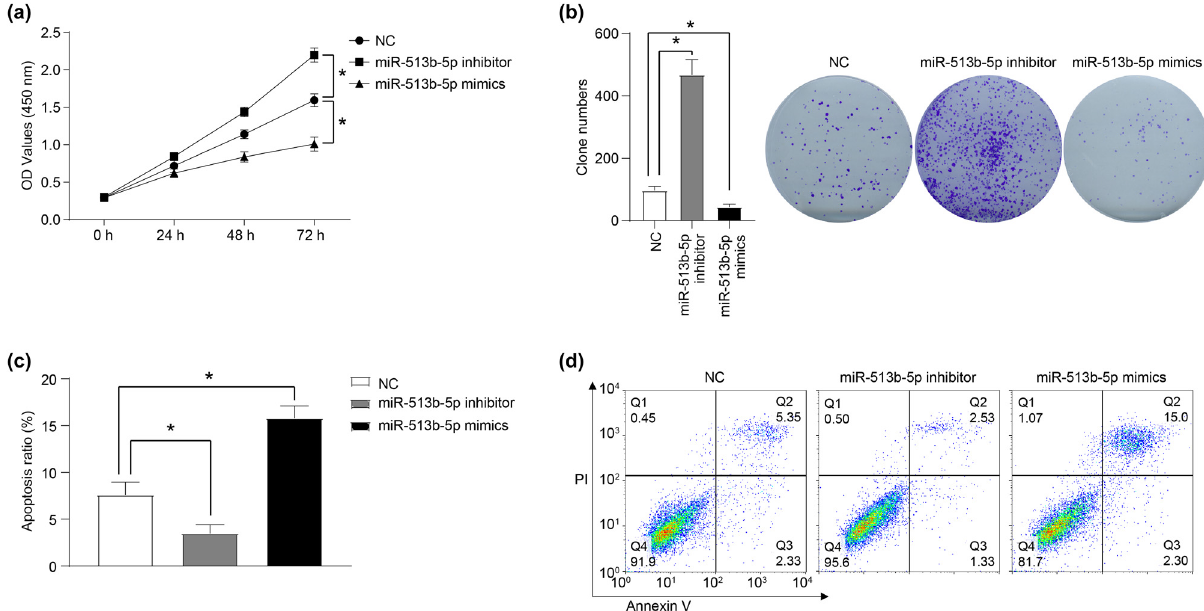
Figure 1: miR - 513b - 5p inhibits the proliferation and promotes the apoptosis of Weri - RB1 cells in vitro . The role of miR - 513b - 5p mimics and inhibitors in the proliferation, clone formation, and apoptosis of Weri - RB1 cells was detected by CCK - 8 ( a ) , clone formation ( b ) , and fl ow cytometry ( c and d ) assays. The di ff erences were evaluated using the Mann – Whitney U - test for pair - wise comparisons. * P < 0.05. Each group of a includes six samples, each group of b – d includes three samples. All experiments were repeated three times independently, and the individual experiments were performed 1 week